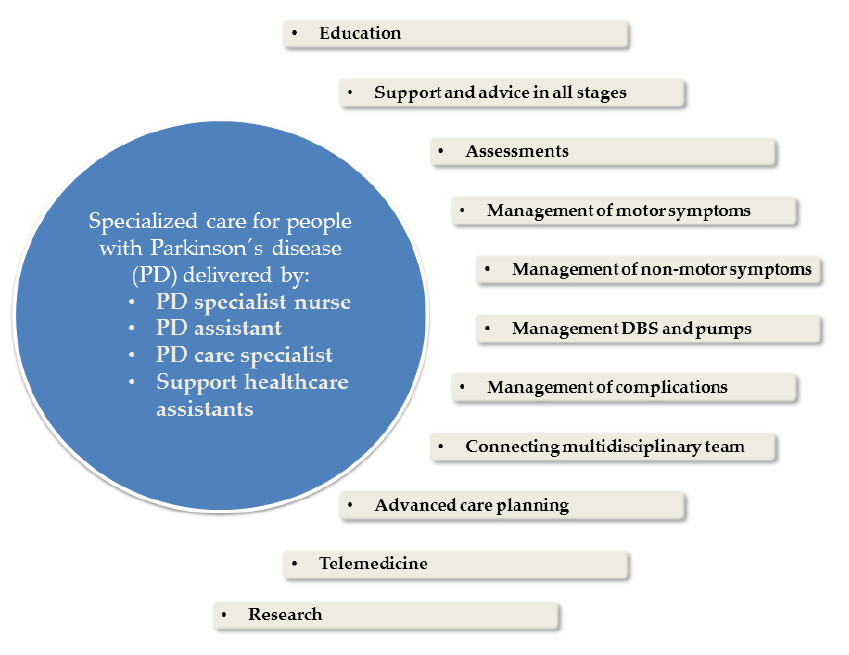
Figure 1. Proposed core elements for future PD staff (PDS) education in Germany.